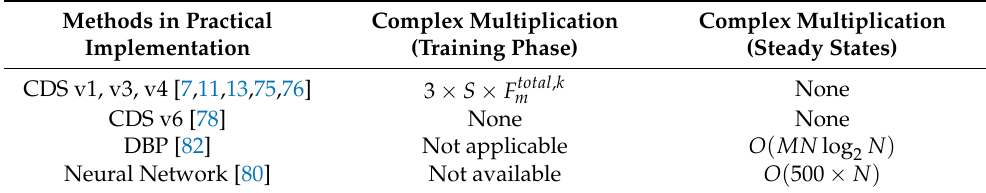
Table 4. In terms of computational complexity, a comparison of CDS and competing